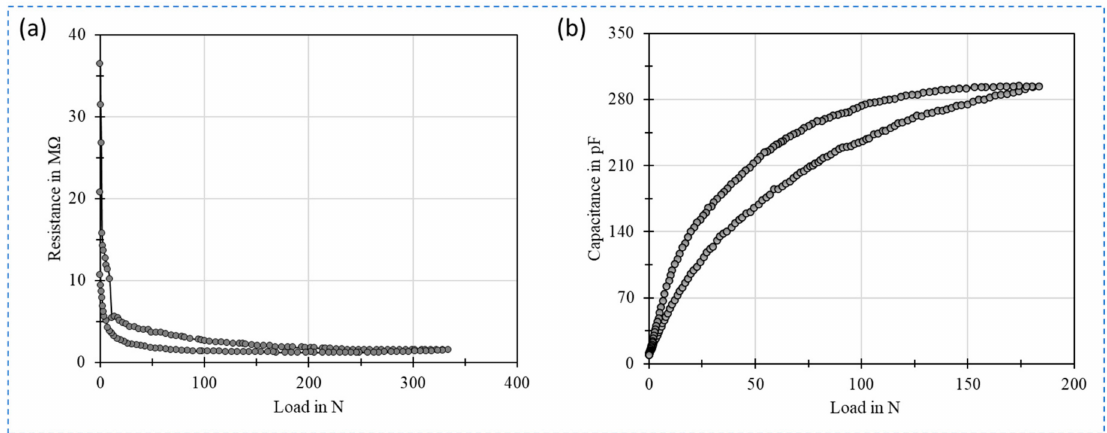
Figure 11. ( a ) Piezoresistive behavior of the sensor and ( b ) piezocapacitive behavior of the sensor. Table 3. Previous research work on pressure sensors. PP—parallel plate structure, IDE—interdigital electrode structure, PR—piezoresistive, PC—piezocapacitive.